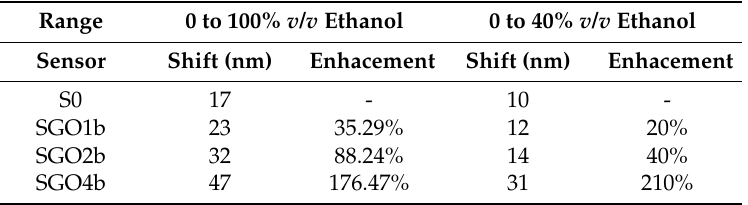
Table 1. Dynamic range of the four studied